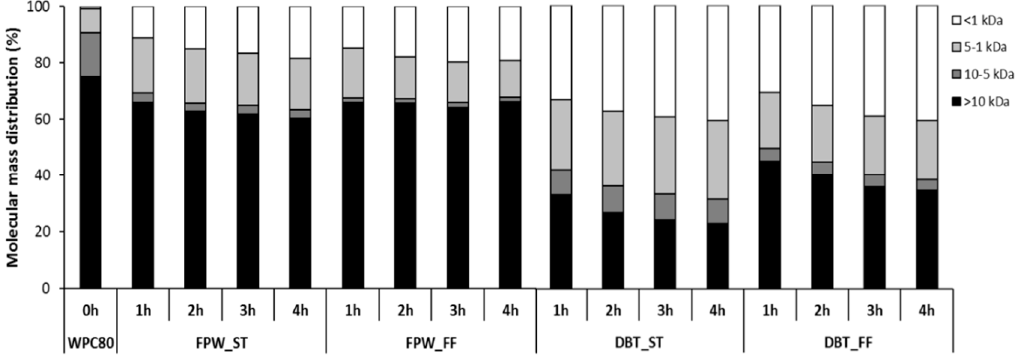
Figure 3. Molecular mass distribution profile of unhydrolysed whey protein concentrate (WPC80) and the whey protein hydrolysates (WPHs) generated using FlavorPro Whey (FPW) and Debitrase (DBT) under pH- and non pH-controlled conditions (ST and FF, respectively) during the course of a 4 h hydrolysis period.